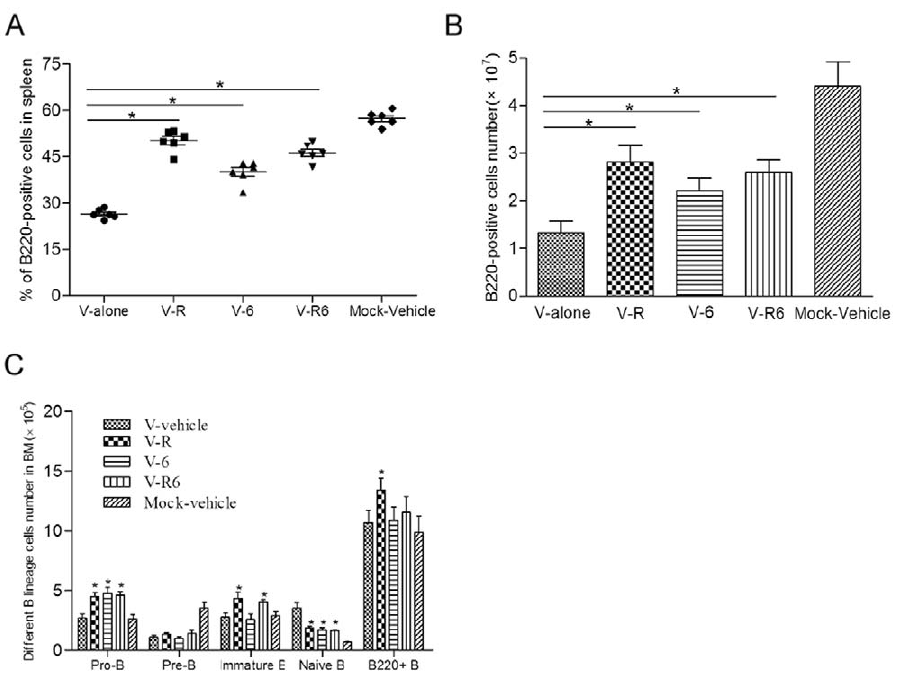
Figure 7. Comparison of spleen and BM B cells from individual and both pathways blockade mice. For this experiment, five groups mice (n=6/group) were prepared. One group (V-6) mice was administrated with 6-OHDA before infection; Second group (V-R) was administrated with RU486 daily during infection; Third group (V-R6) was administrated with 6-OHDA before infection and RU486 daily during infection; Forth group (V- vehicle) was administrated with vehicle (2% ethyl alcohol ethyl alcohol). All the four groups were received with 104 PFU of V virus. The fifth group (Mock-vehicle) was administrated with vehicle and received with PBS as mock group. At day 5 post-infection, spleen and BM cells were prepared. The proportions (A) and numbers (B) of splenic B220 + B cells were determined. The numbers of pro-, pre-, immature B cells and mature naı¨ve B cells from BM (C) were calculated by multiplying the percentage by number of total BM cells. Data bars represent means 6 SD. * p , 0.05 and ** p , 0.01 between V-vehicle and